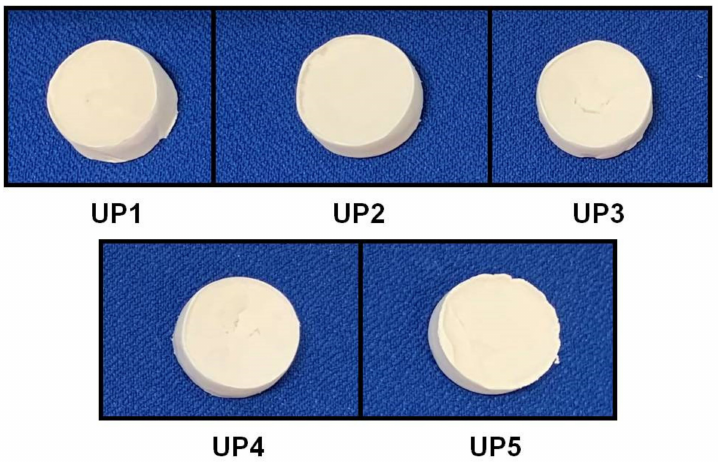
Figure 1. Images of the ulvan/polycaprolactone (UP)